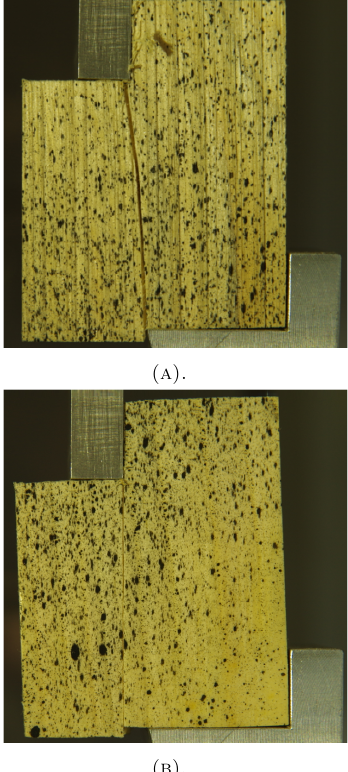
Figure 4. The final fracture of the shear-parallel-to- grain test according to the standard ASTM D143-94: (A) the specimen S1 and (B) the specimen S3.